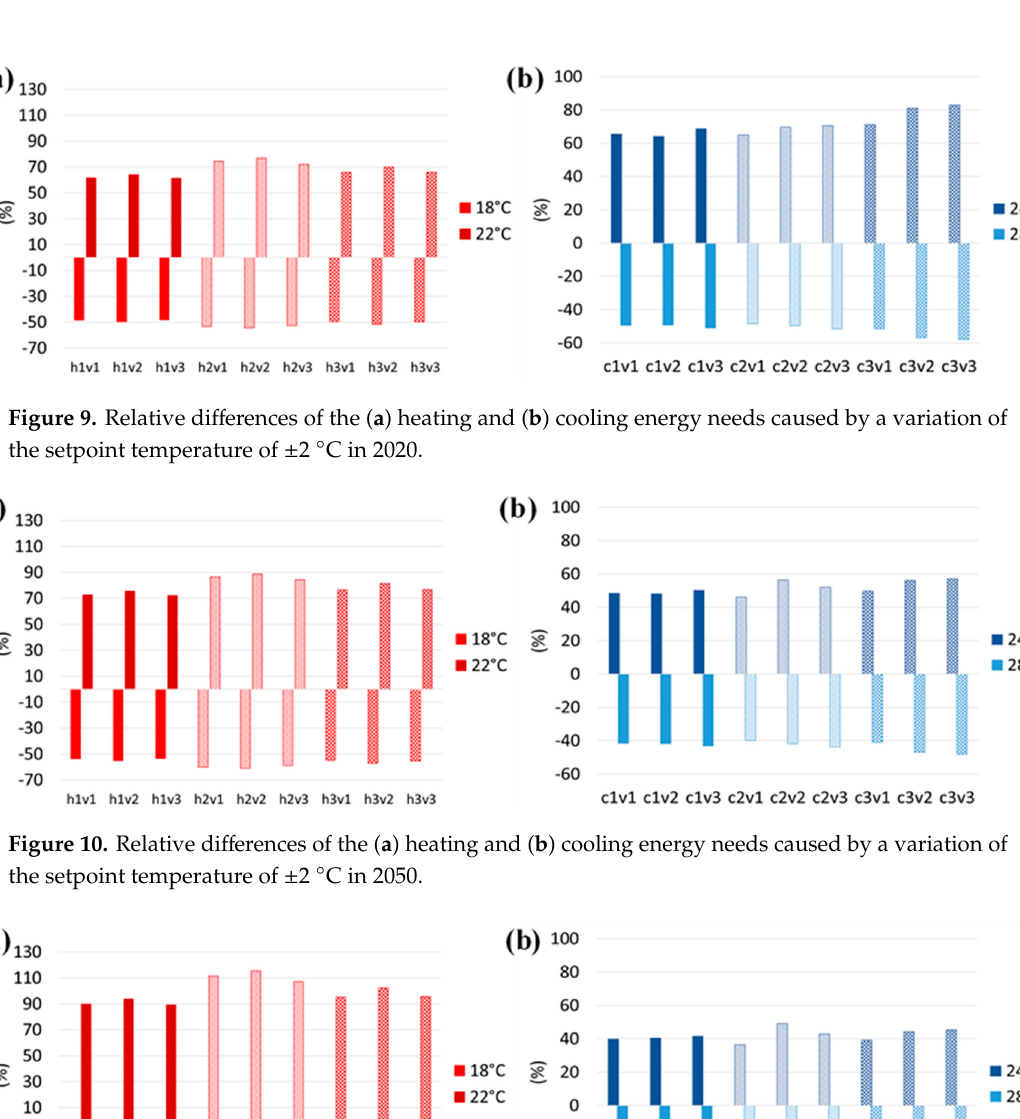
Figure 11. Relative differences of the ( a ) heating and ( b ) cooling energy needs caused by a variation of the setpoint temperature of ±2 °C in 2080.